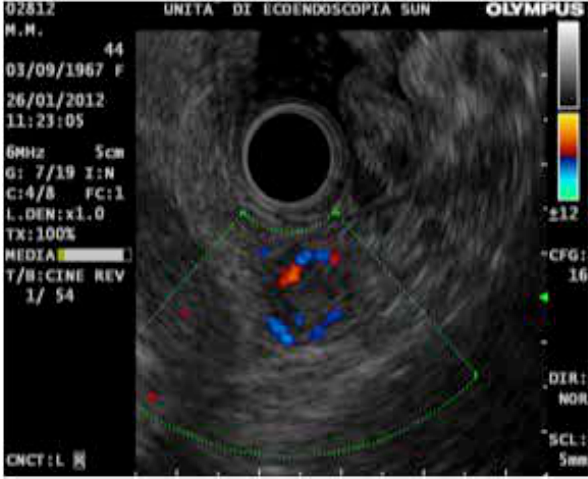
Figure 3: Insulinoma corpo